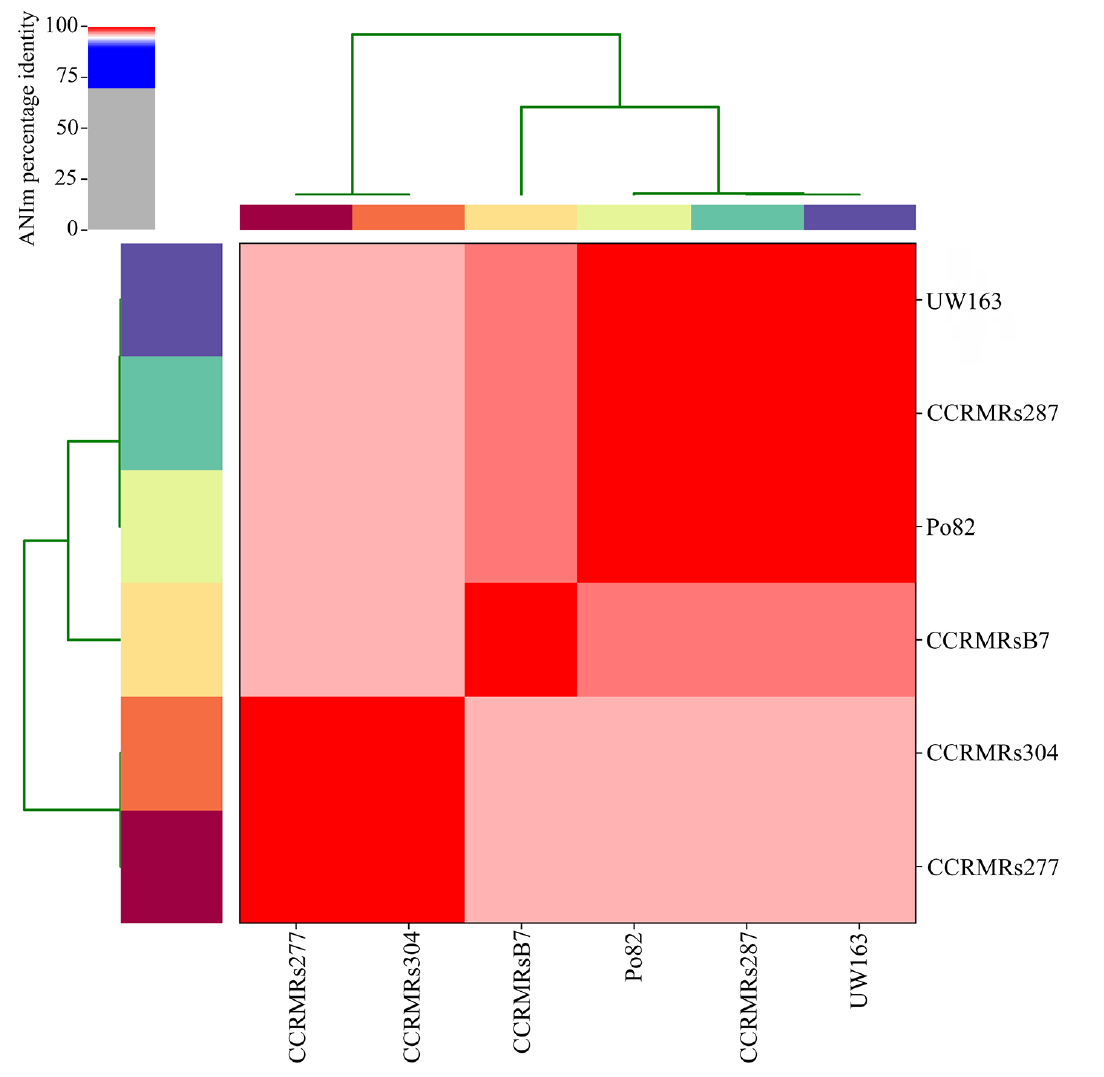
Figure 1 - Average Nucleotide Identity (ANIm) of four R. solanacearum strains belonging to the Moko ecotype (CCRMRs277, sequevar IIA-24; CCRMRs287, sequevar IIB-4; CCRMRs304, sequevar IIA-24; and CCRMRsB7, sequevar IIB-25) from Brazil, as well as the employed reference strains (UW163 and Po82, sequevar